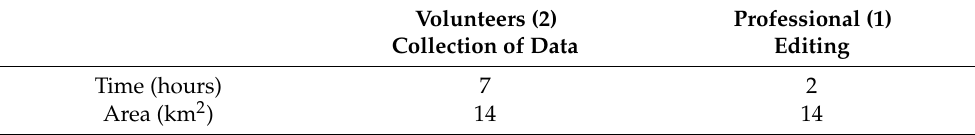
Table 2. Required man-hours for data collection and editing for the case study